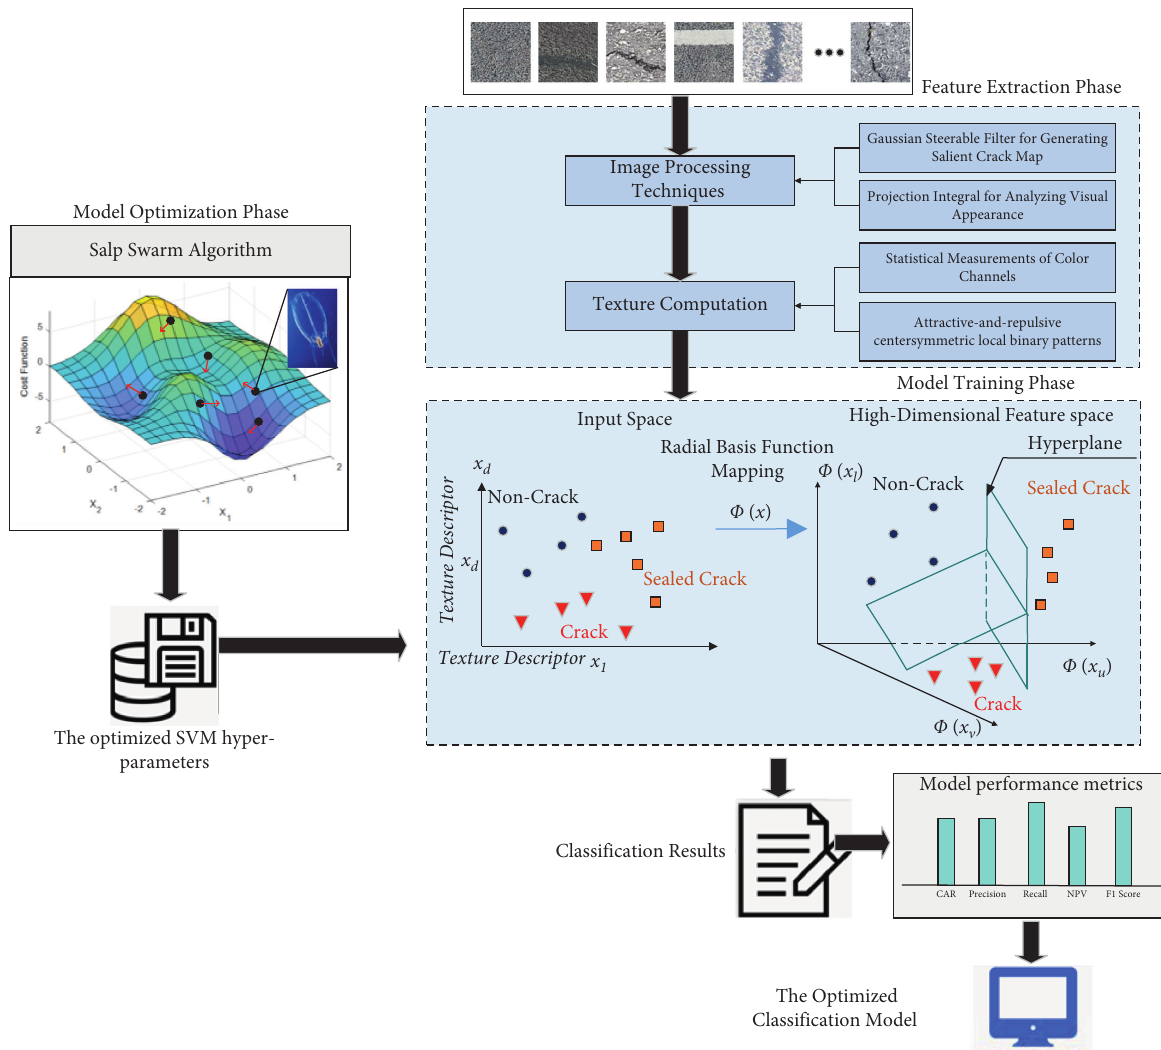
Figure 7: The proposed hybrid method for the classification of crack and sealed